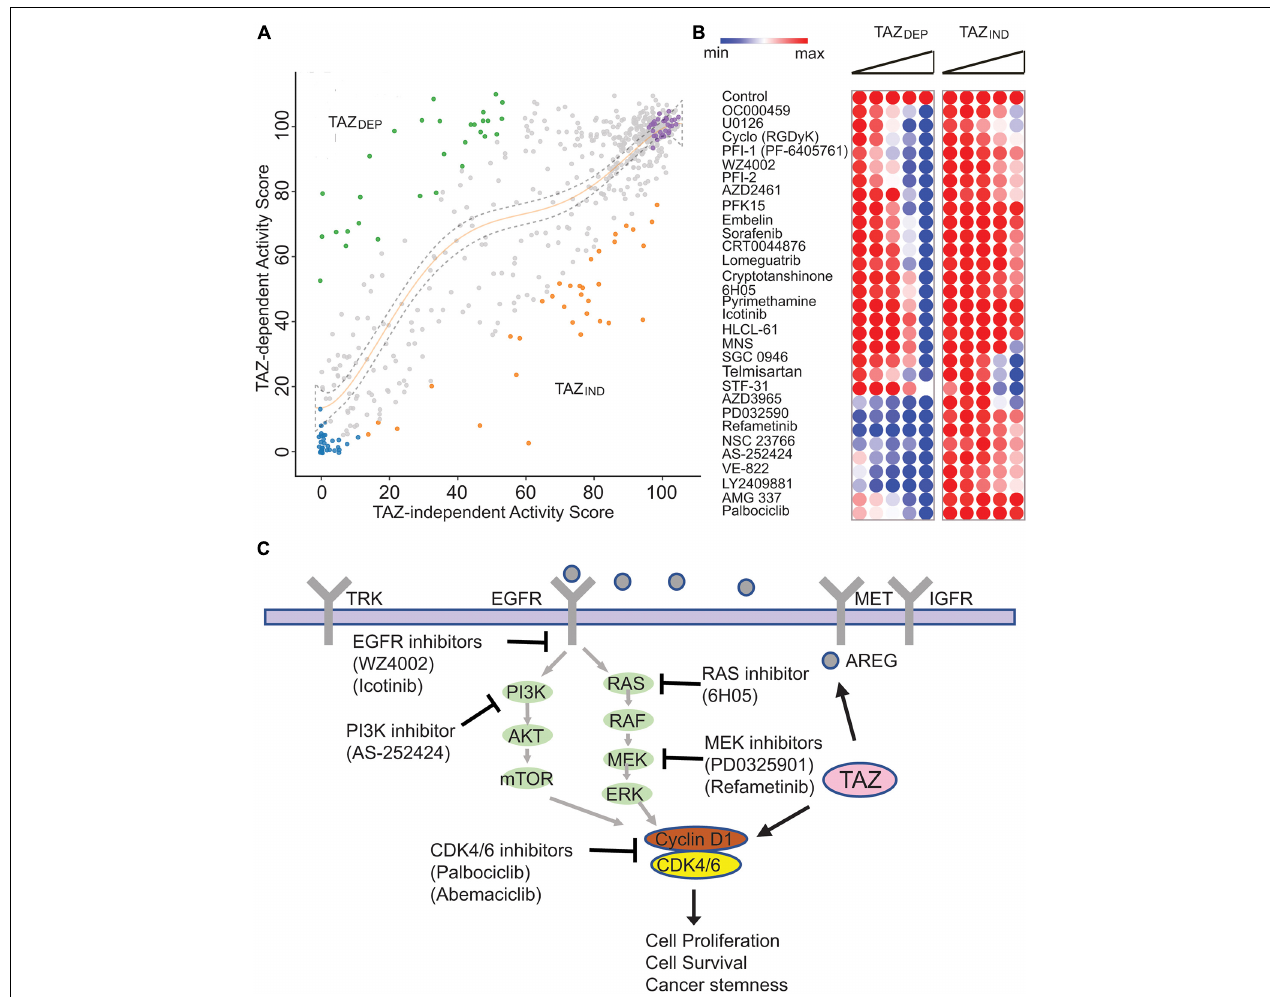
FIGURE 5 | Small molecule library screen identified isogenic cell line vulnerabilities. (A) Results of the small molecule screen representing the relative viability of TAZ DEP (y axis) and TAZ IND (x axis). Polynomial regression was used to identify non-linear relationships between TAZ DEP and TAZ IND cells. (B) Heatmap of TAZ DEP and TAZ IND cells in response to 30 compounds. Doses from low to high are 0.65, 1.25, 2.5, 5, and 10 µ M, respectively. (C) Summary of TAZ DEP small molecule hits and their predicted